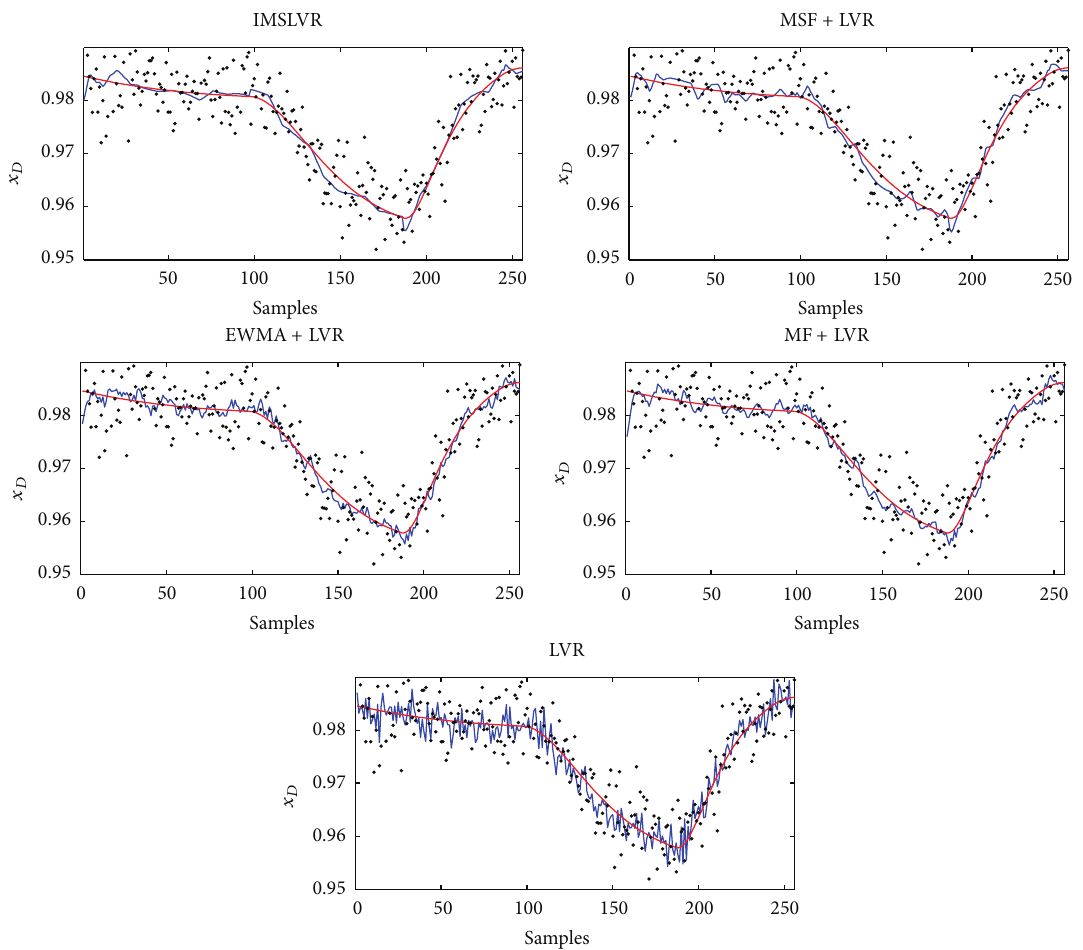
Figure 7: Comparison of the RCCA model predictions of 𝑥 𝐷 using the various LVR (RCCA) modeling techniques for the simulated dis- tillation column example and the case where the noise SNR = 10 (solid blue line: model prediction; black dots: noisy data; solid red line: noise-free